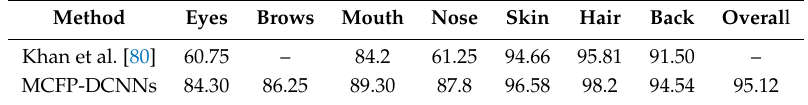
Table 3. Face parsing: comparison of the MCFP-DCNN with SOA on FASSEG (frontal) DB. The reported results are based on pixel labeling accuracy.